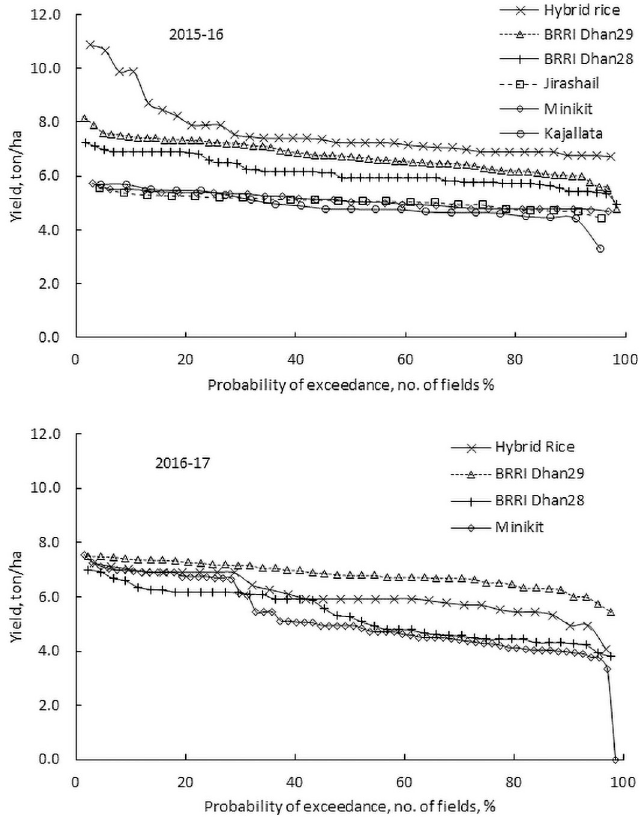
Fig 6. Probability of yields of different Boro rice varieties cultivated at different sites in 2015–16 and 2016–17.